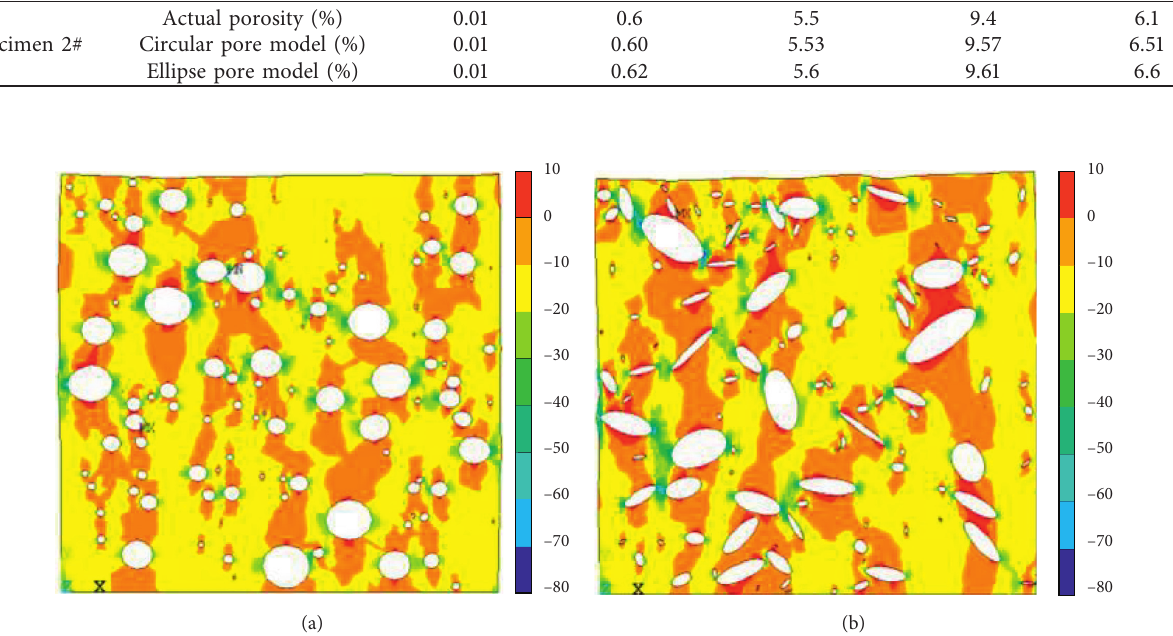
Figure 11: Stress cloud in simulation model for specimen 1#: (a) random circular pores model; (b) random ellipse pores